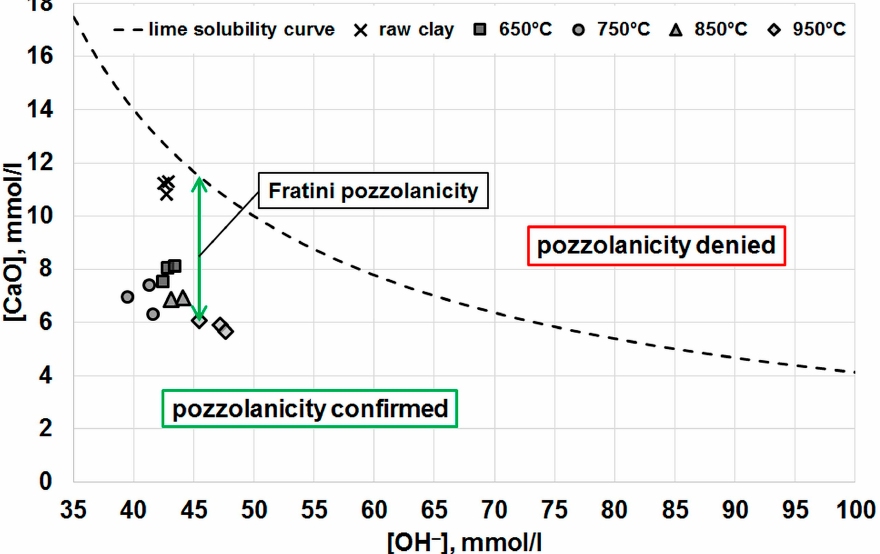
Figure 3. Results of the Fratini pozzolanity test.